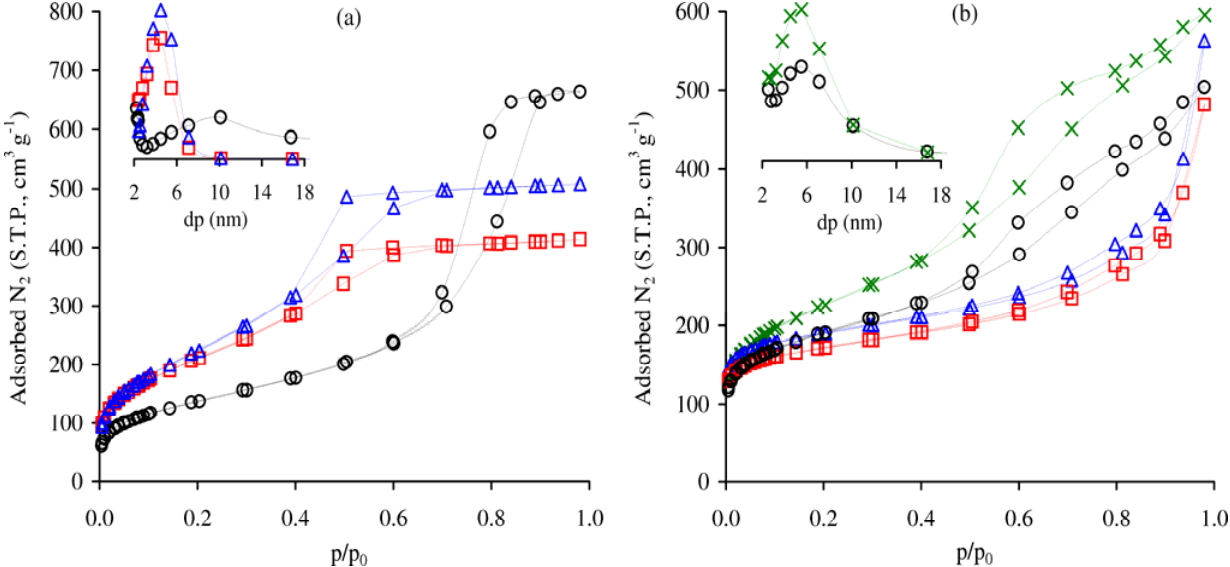
Figure 2. N adsorption-desorption isotherms at − 196 °C of ( a ) Al-TUD-1 ( □ ), 2 CrAl-TUD-1 (  ), Cr-TUD-1 ( ○ ), and ( b ) BEA ( □ ), Cr-BEA (  ), BEA/TUD-1 ( ○ ), Cr-BEA/TUD-1 (  ). The insets show the PSD curves (dp is the pore width) for the respective materials (with matching